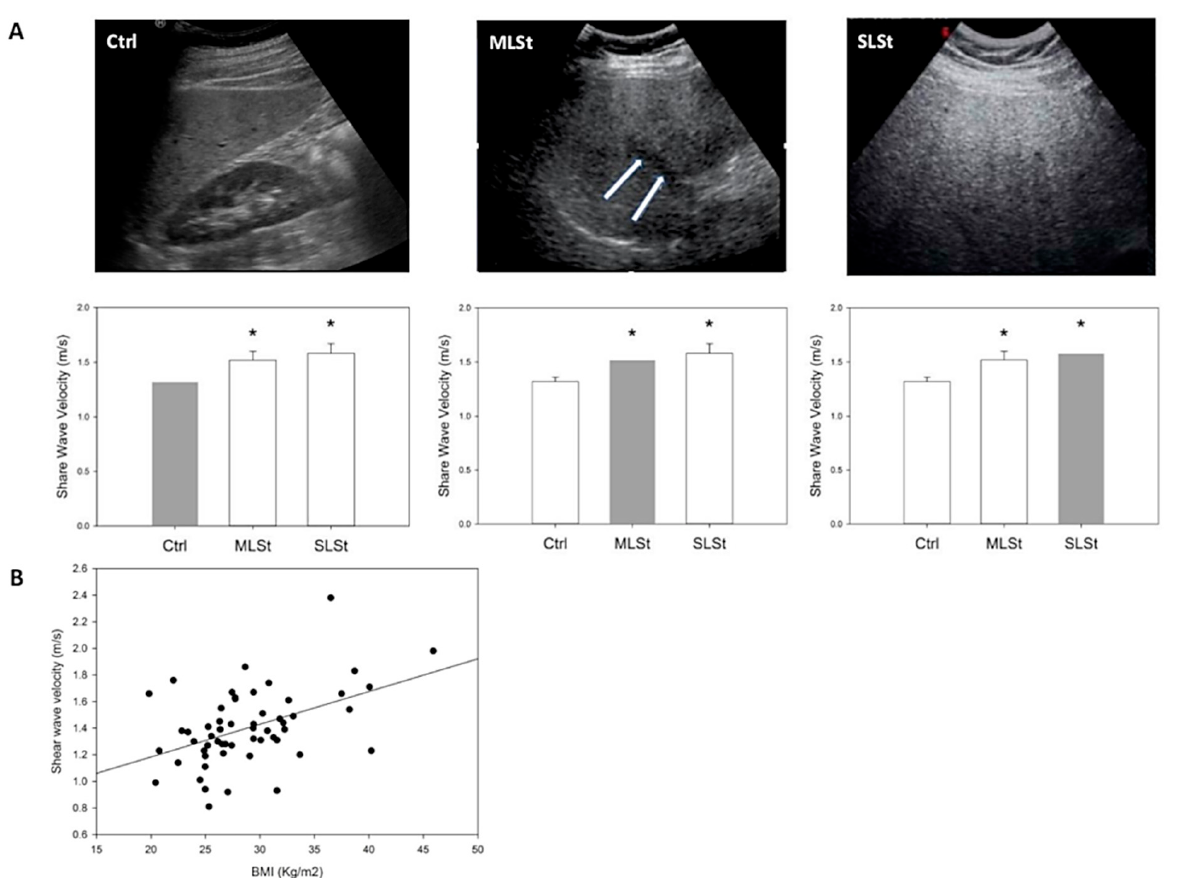
Figure 1. In vivo liver stiffness and serum biomarkers measurements. ( A ) Ultrasonographic grad- ing of liver steatosis (upper figures) and corresponding average shear wave velocity (lower graphs, red bars). Ctrl (absent/mild steatosis): a normal liver echogenicity or isolate finding of liver echogenic- ity brighter than the renal cortex; MLSt (moderate steatosis): liver echogenicity brighter than the renal cortex, associated with hepatic and/or portal venous margin blurring (arrows); SLSt (severe steatosis): additional presence of diaphragmatic ultrasound wave attenuation. Asterisks indicate significantly higher average shear wave velocity values in moderate and severe steatosis, as compared with normal/mild steatosis (ANOVA followed by Fisher’s LSD Multiple-Comparison test). ( B ) Linear regression analysis between Body Mass Index (Kg/m 2 ) and acoustic radiation force impulse shear wave velocity (a value directly proportional to local tissue stiffness), measured in a group of 60 adults. R = 0.46, p =